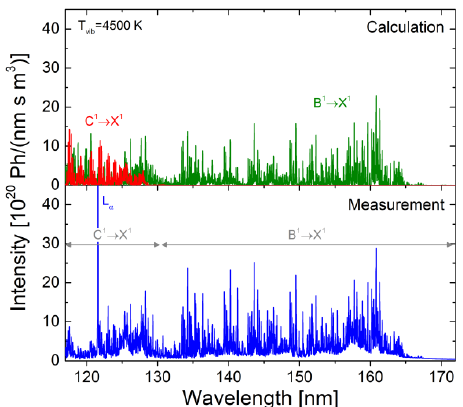
Figure 12. VUV/UV spectra for molecular hydrogen: ( a ) calculated by the corona model; ( b ) measured in an inductively coupled plasma (ICP) discharge.